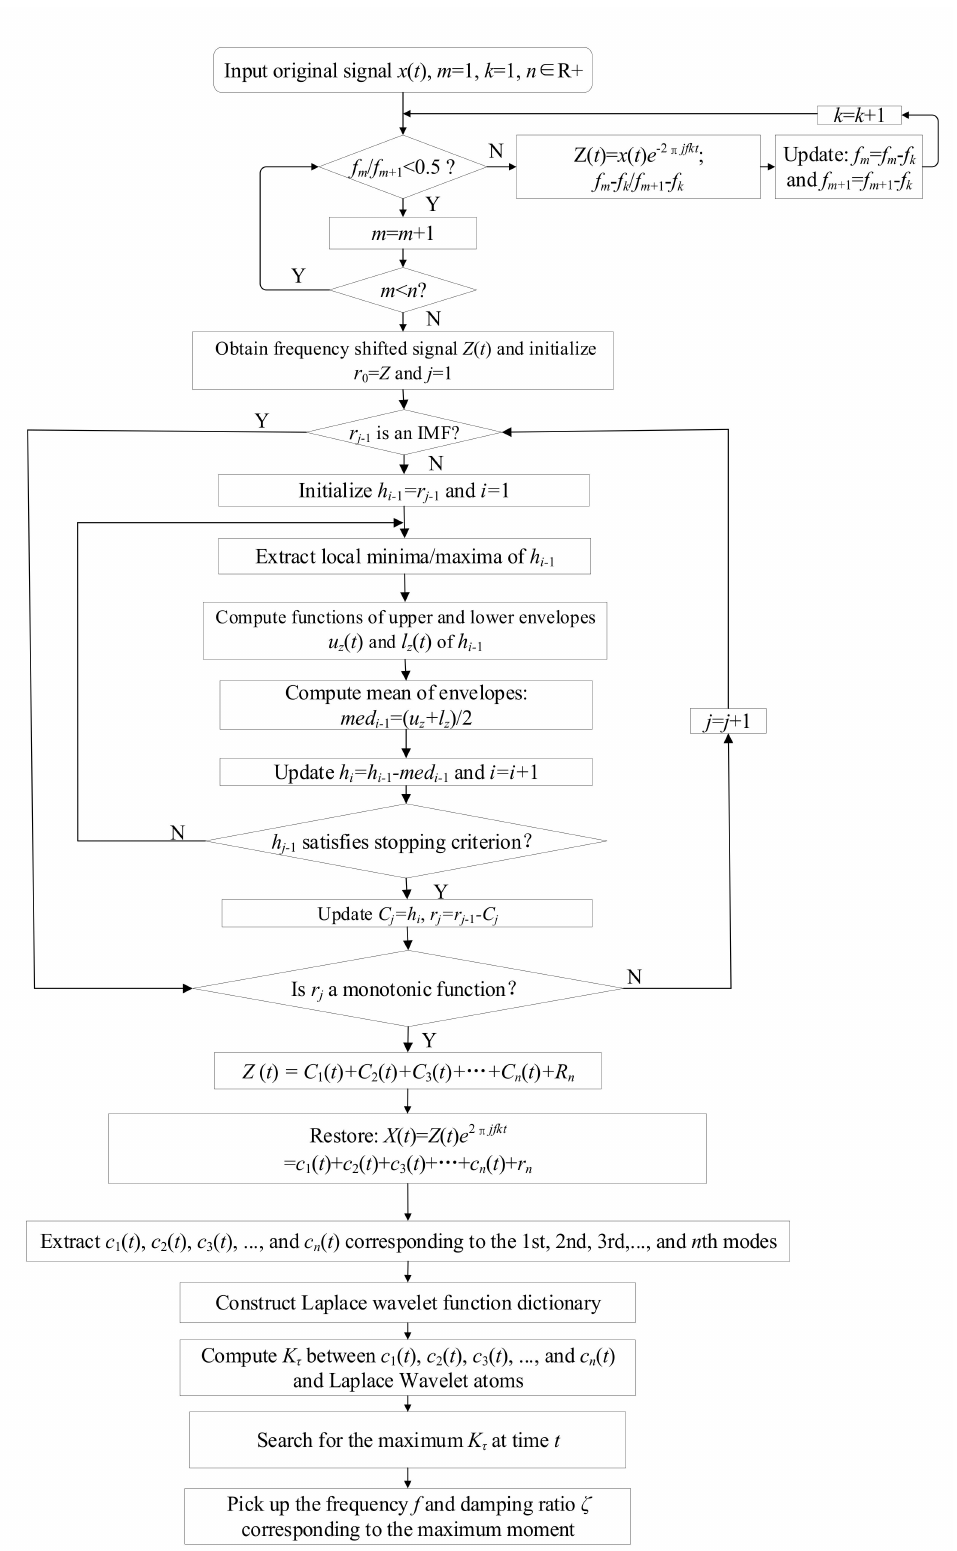
Figure 3. Flow chart of the proposed method for non-destructive health